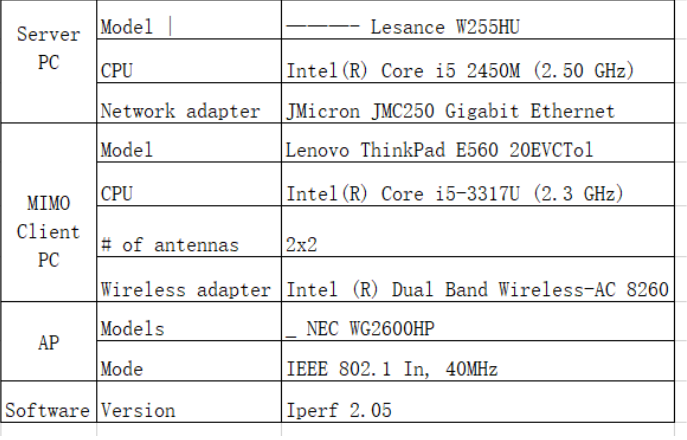
Figure 30. Excel output for scanned table image 6 by our algorithm.